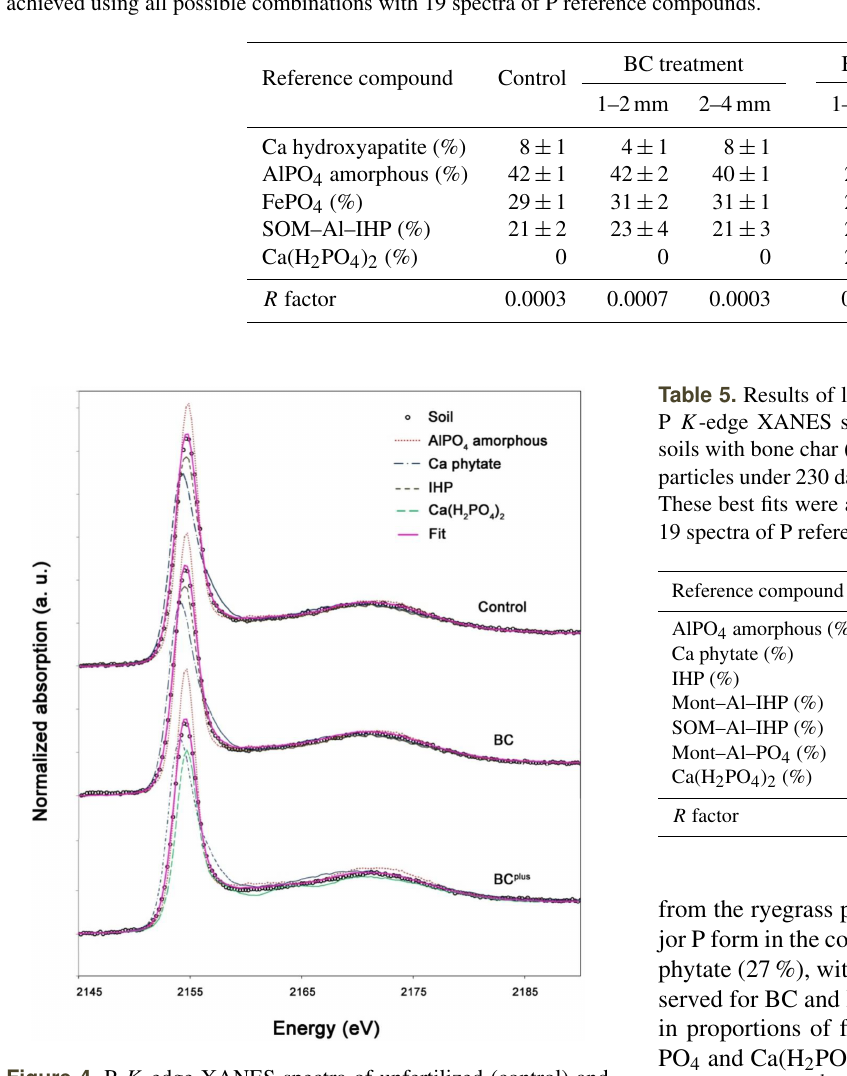
Table 4. Results of linear combination fitting (LCF) conducted on P K -edge XANES spectra of unfertilized (control) and fertilized soils with bone char (BC) and surface-modified bone char (BC plus ) particles in the 70-day incubation-leaching experiment. These best fits were achieved using all possible combinations with 19 spectra of P reference compounds.